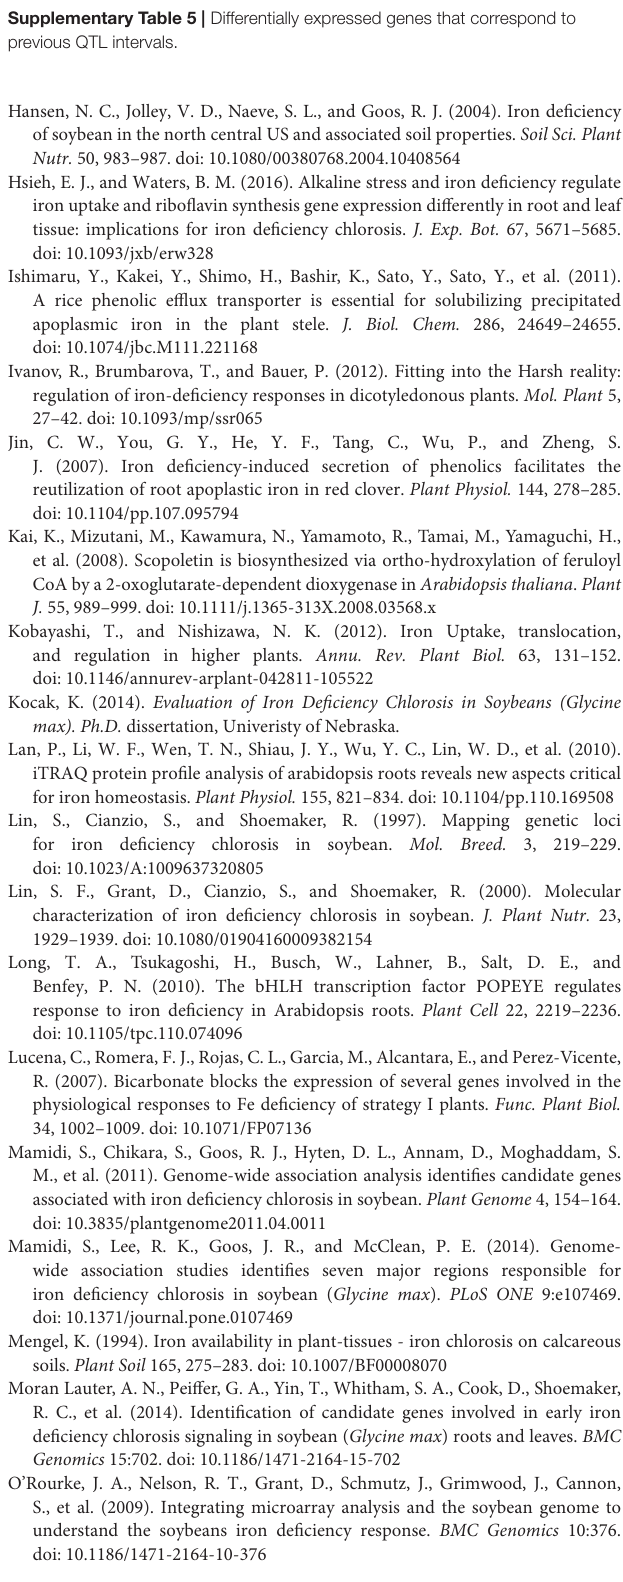
Supplementary Table 4 | Thousand six hundred and twenty-six genes that were differentially expressed between genotypes and also were differentially expressed by Fe or Bic treatments. Supplementary Table 5 | Differentially expressed genes that correspond to previous QTL